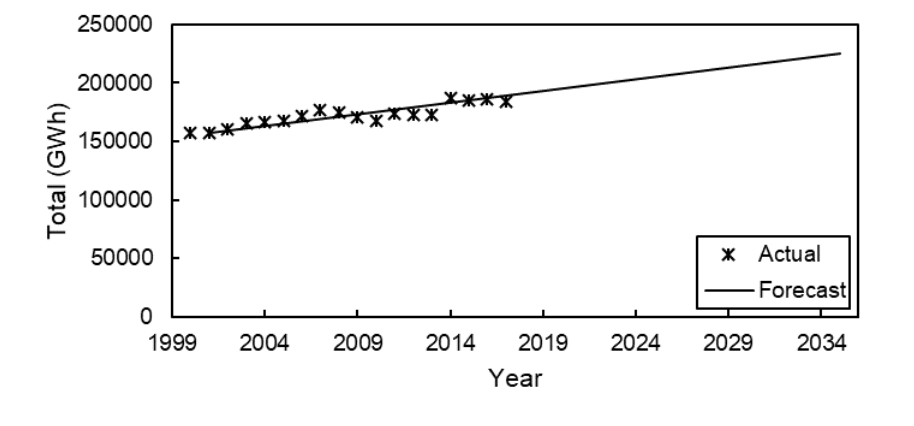
Figure 7: Electricity demand forecasting for total consumption in Ukraine (standard error =